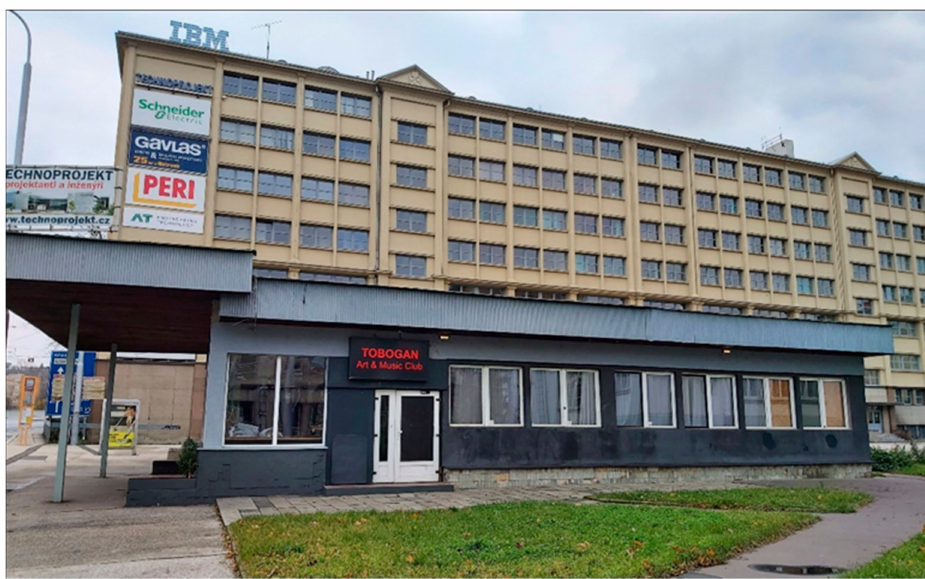
Figure 5. Building in Hub A (office centre “Na N á bˇrež í